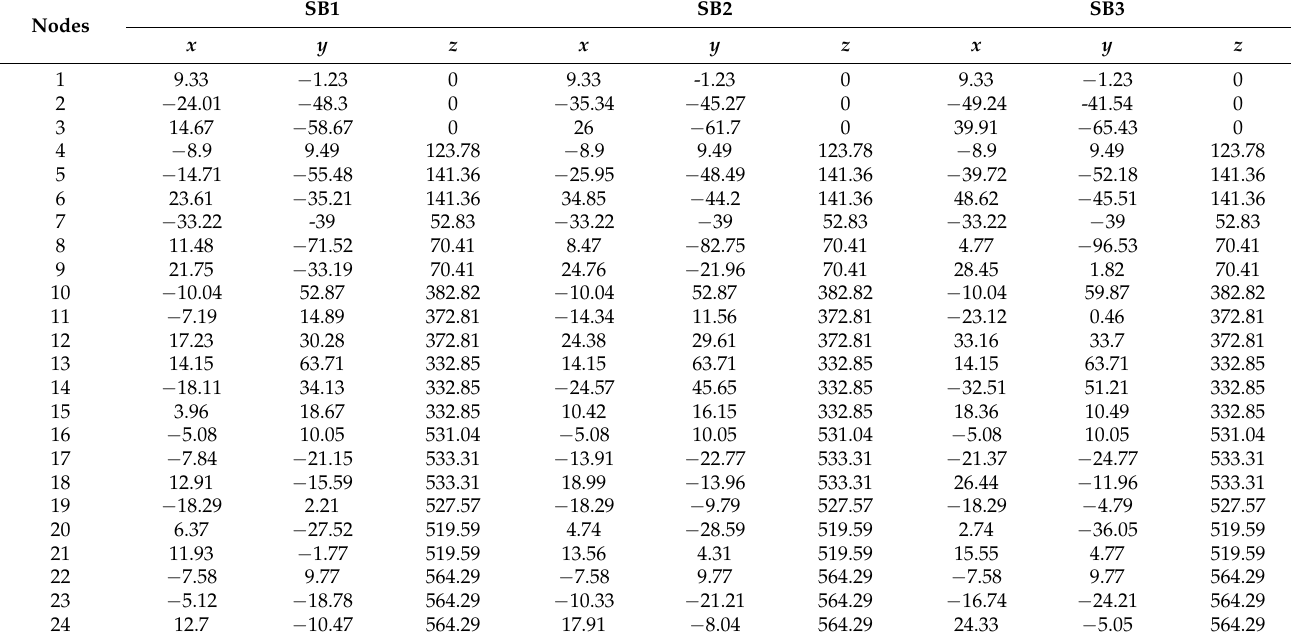
Table A1. Nodal coordinates of SB1, SB2 and SB3